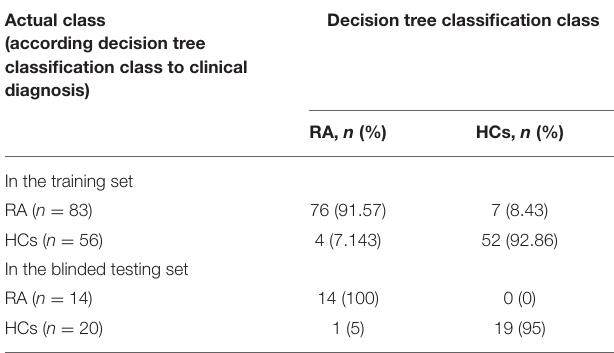
TABLE 3 | Prediction success of classification tree model for